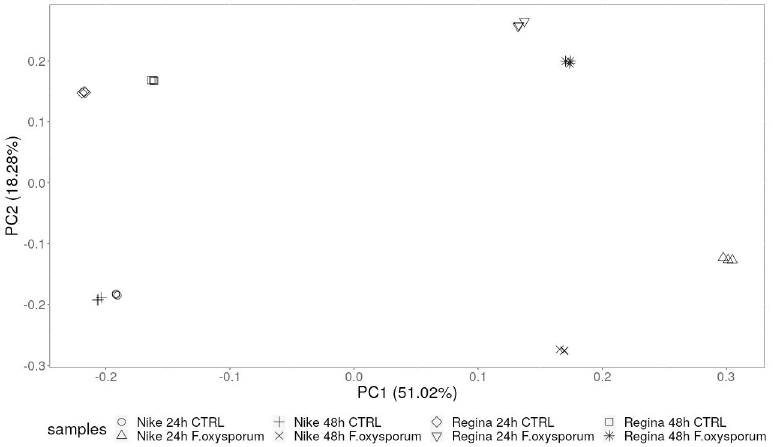
Fig 1. Principle component analysis on transcriptome data from flax seedlings of the resistant and susceptible cultivars infected with F . oxysporum .